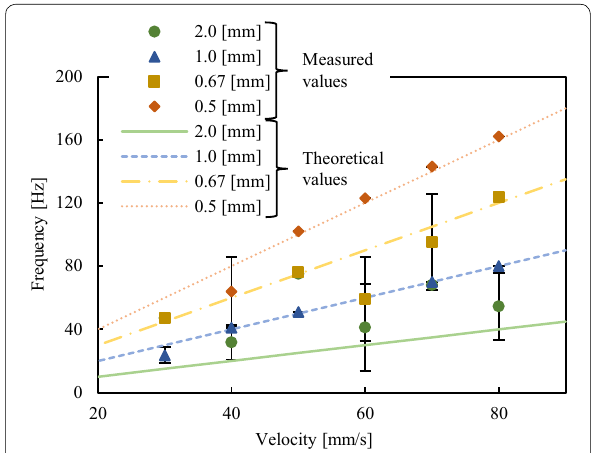
Fig. 14 Maximum amplitude frequency (blood vessel model No. 2)